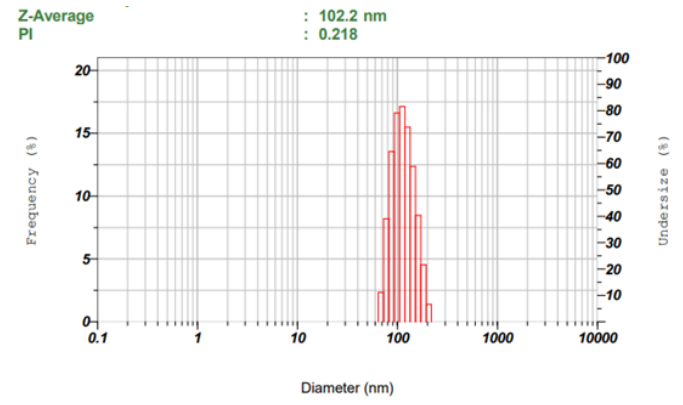
Figure 4. Particle size distribution of optimized batch (NC).